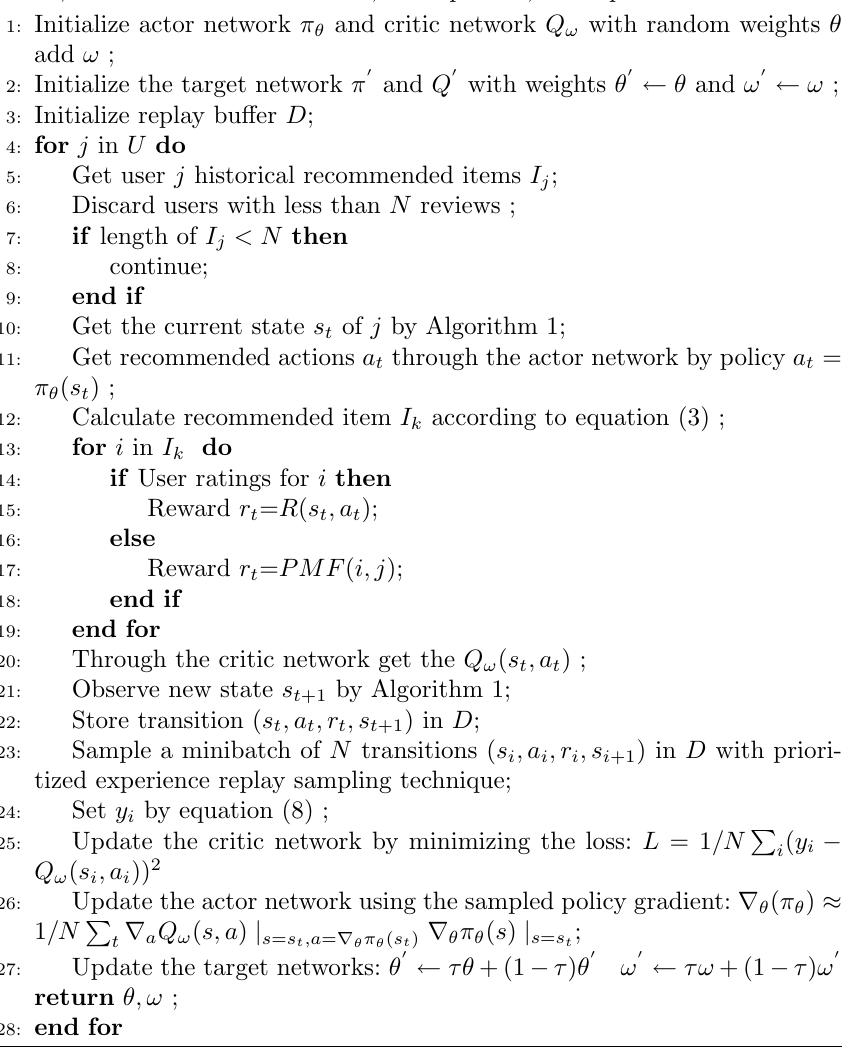
Algorithm 2 Offine Train